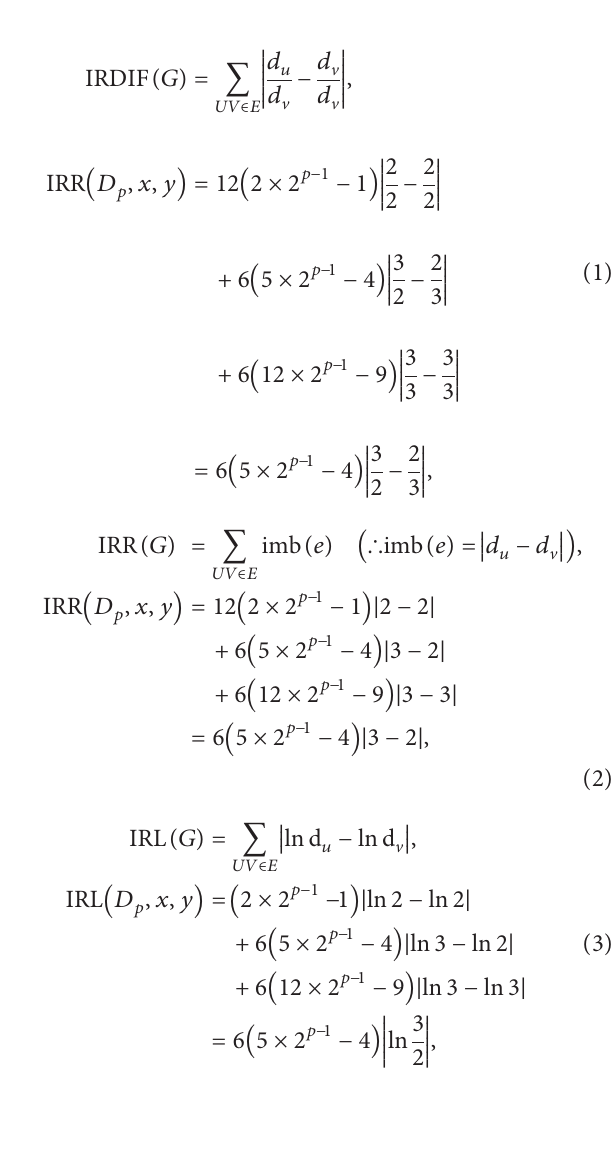
p � 1 shown in (a) and for p � 2 shown in (b). p for